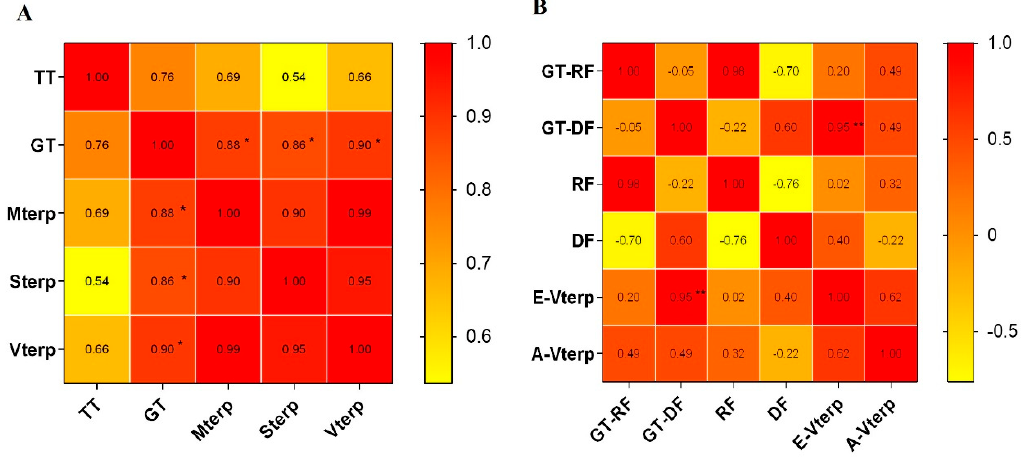
Figure 6. Pearson analysis of the correlation between terpene compounds and the density of glandular trichomes in leaves ( A ) and in flowerheads in the break bud stage ( B ) in six Chrysanthemum cultivars/accessions. TT: T-type trichome; GT: glandular trichome; Mterp: monoterpenoids; Sterp: sesquiterpenoids; Vterp: volatile terpenoids; GT-RF: glandular trichomes of ray florets; GT-DF: glandular trichomes of disc florets; RF: ray florets; DF: disc florets; E-Vterp: emission rate of volatile terpenoids; A-Vterp: accumulation of volatile terpenoids. The color scale ranging from yellow (value,0) to red (value,1) represents the relevant correlation. ** significant at the level of p < 0.01; * p < 0.05.